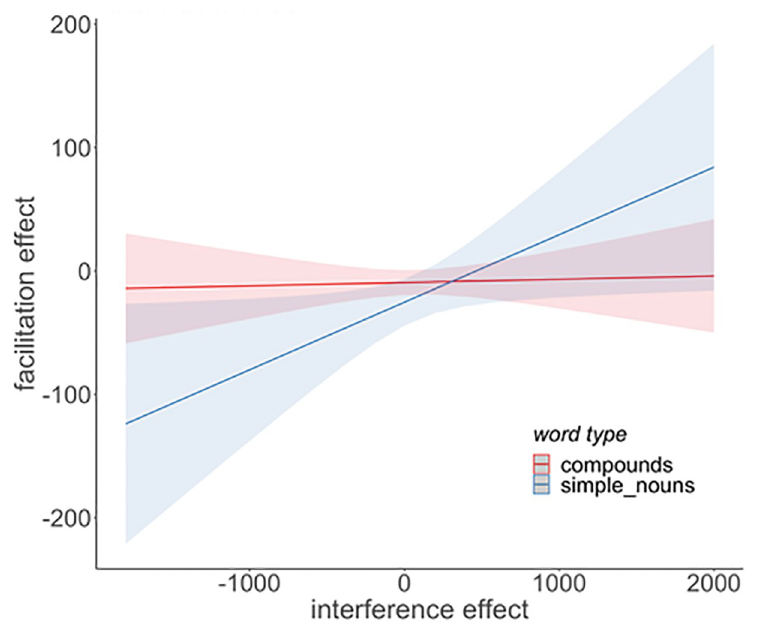
Fig 5. Predicted facilitation effect of Experiment 2 (in ms) by the interference effect observed in Experiment 1 (in ms), broken down by word type condition. Interference can only predict facilitation of simple nouns but not of